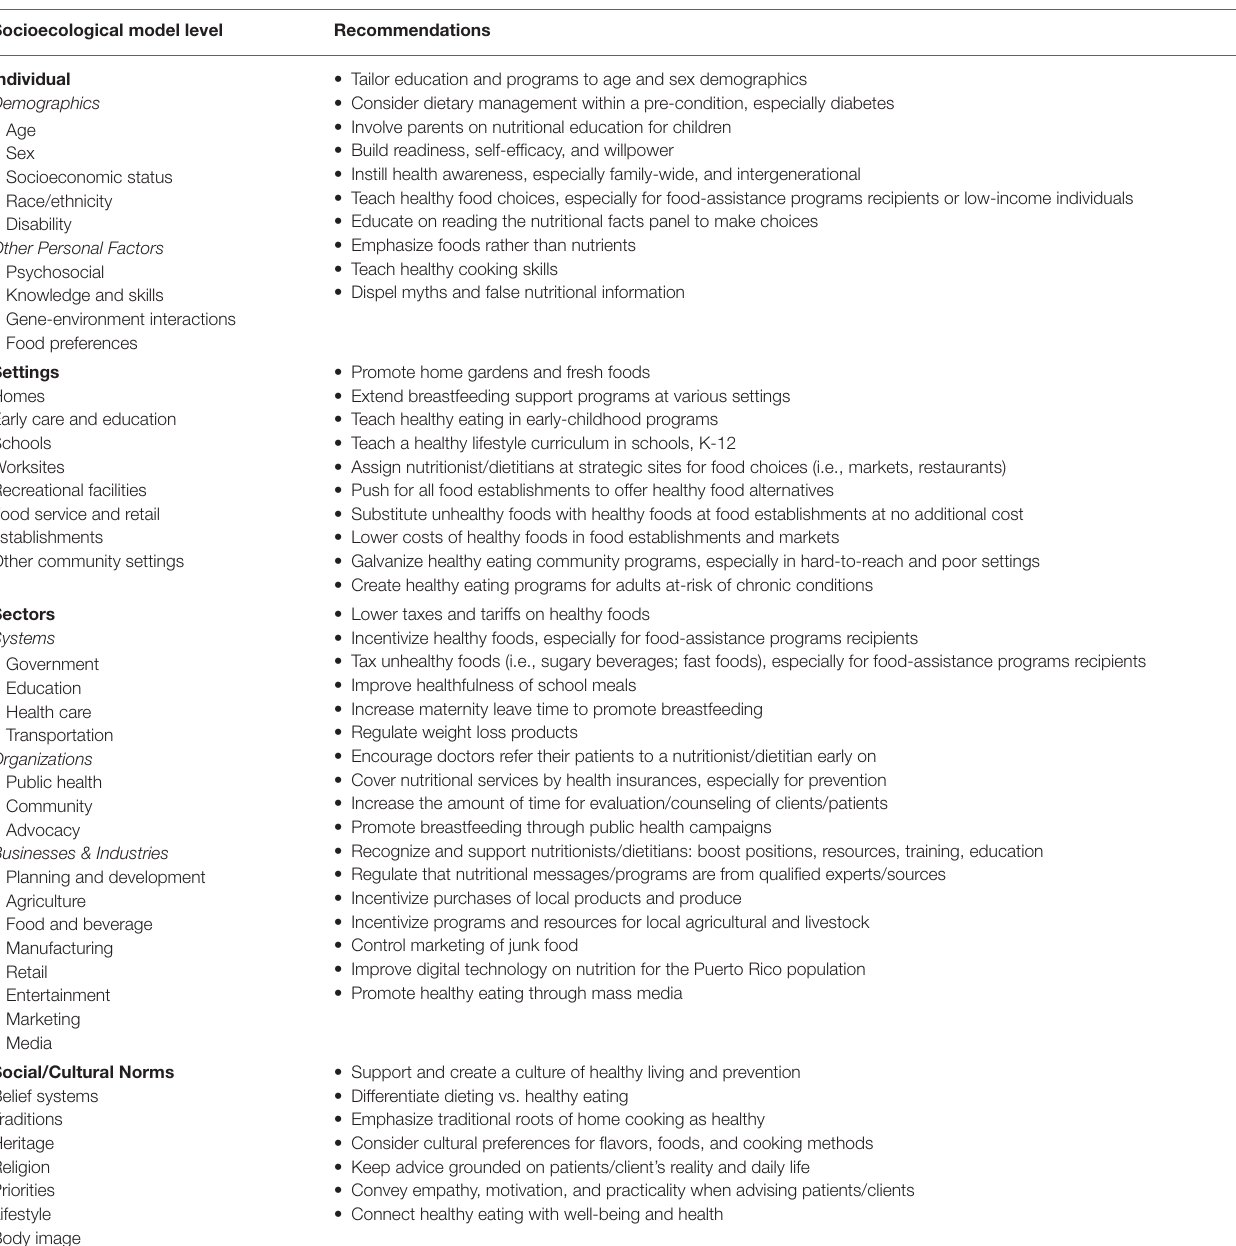
TABLE 2 | Recommendations to improve healthy eating framed within the Social-Ecological Model for Food and Physical Activity Decisions, based on results from a mixed-methods study among nutrition professionals. Socioecological model